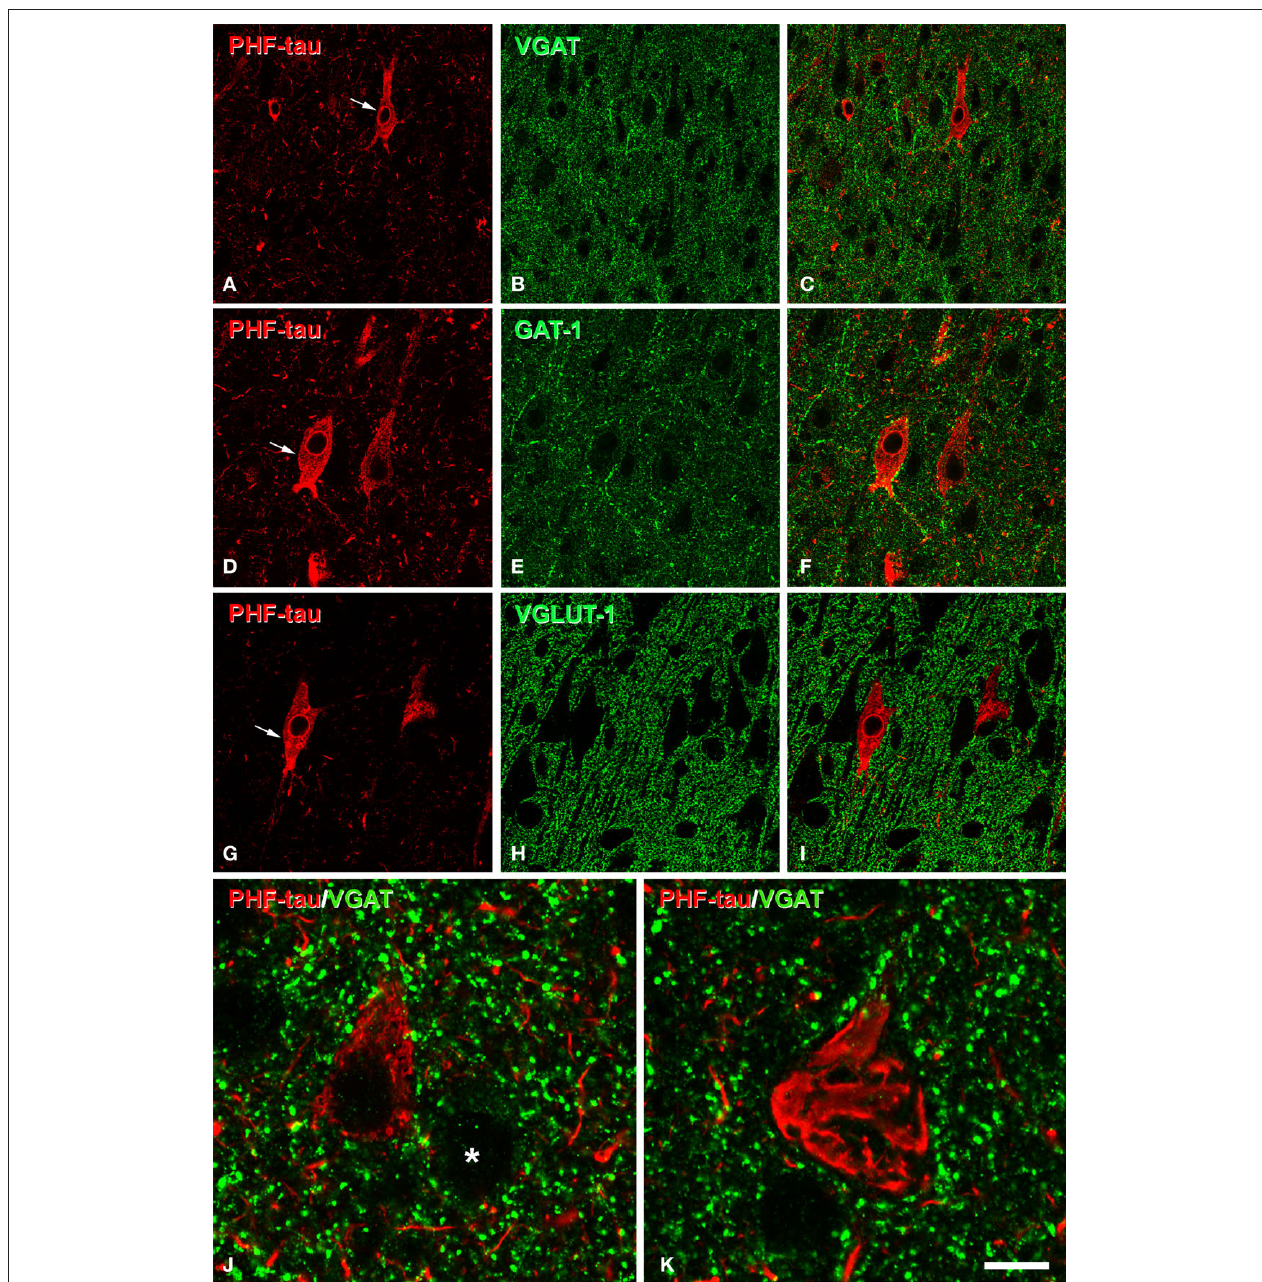
FiGure 10 | (A,B), (D,e) (G,H), pairs of confocal images from the same section and field showing the distribution of GABAergic (VGAT-ir and GAT-1-ir) and glutamatergic (VGLUT-1-ir) perisomatic axon terminals (green) around the cell body of PHF-tau-negative neurons and PHF-tau-ir neurons with type I staining (red) in the CA2 of patient P7 (A,B) , CA1 of patient P7 (D,e) , and CA1 of patient P3 (G,H) . Arrows indicate some type I PHF-tau-ir neurons.